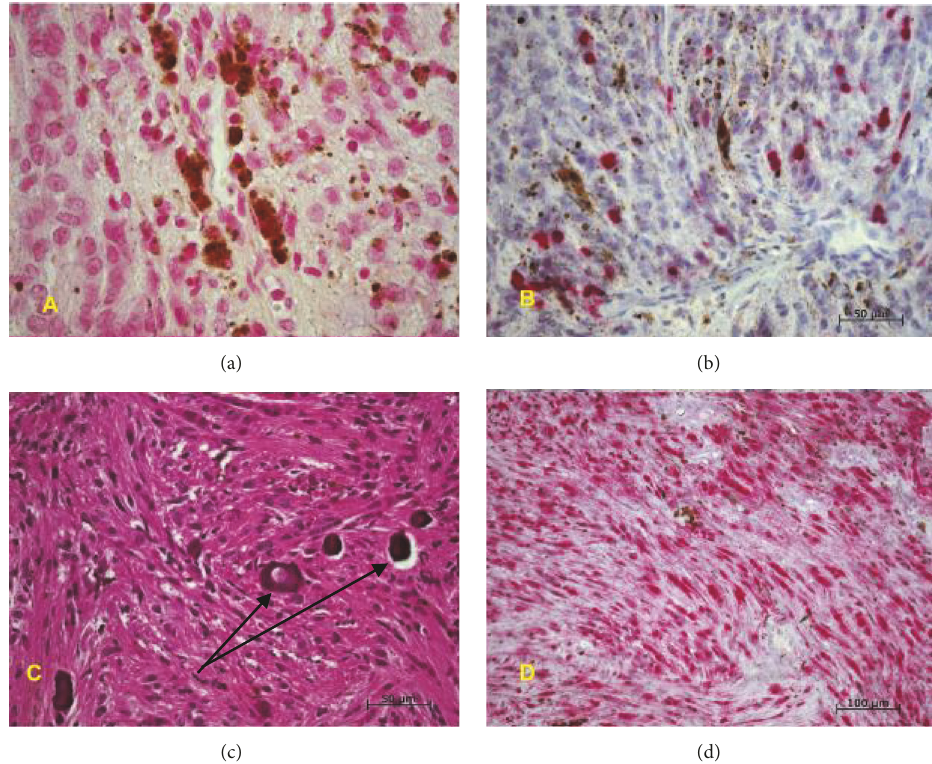
Figure 3: (a) Negative Turnbull’s blue histochemical stain for iron, (b) MIB-1(Ki-67) immunohistochemical stain showing low proliferative index, (c) Hematoxylin and Eosin stain showing psammoma bodies (arrows), (d) positive S-100 immunohistochemical stain.